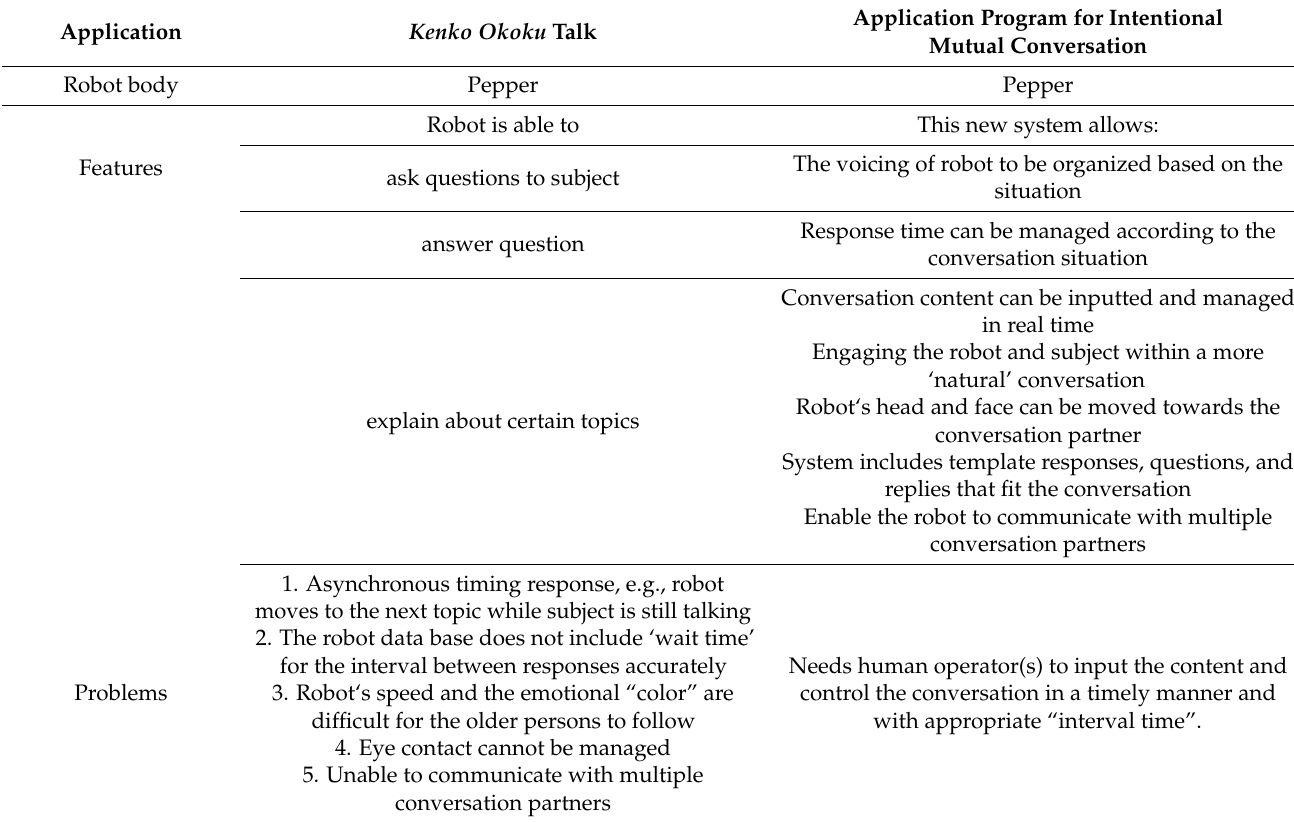
Table 1. Comparison of Kenko Okoku Talk and the application program developed for intentional mutual conversation.